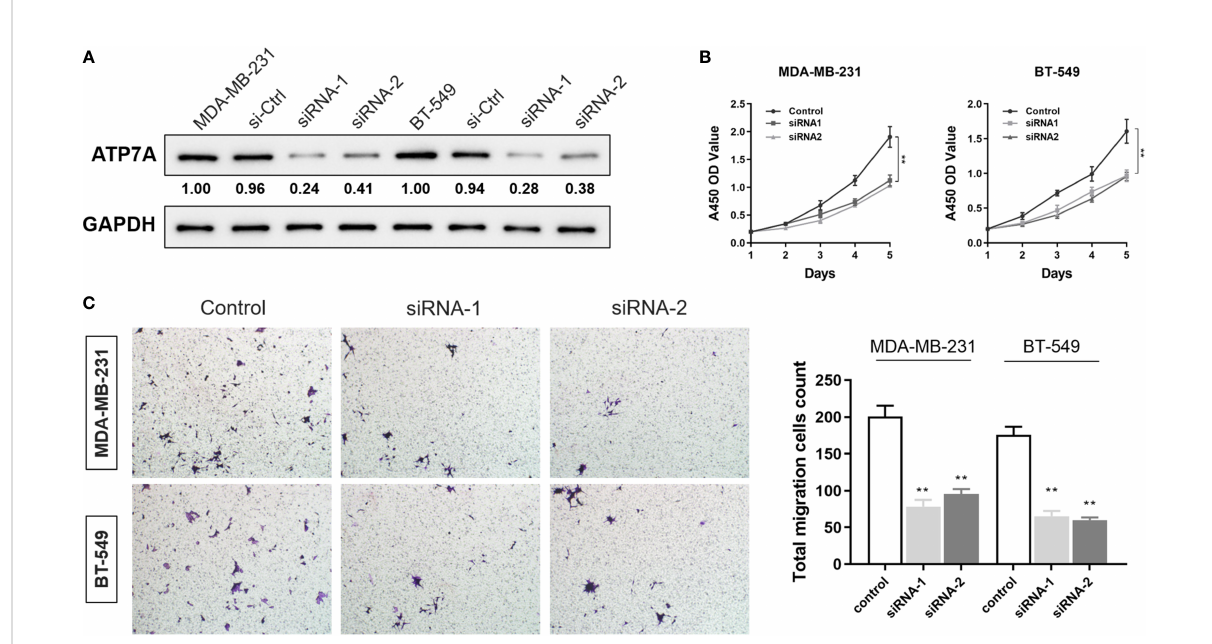
FIGURE 12 Inhibition of ATP7A restrained proliferation and migration capacities of breast cancer cells (A) Western blot analysis revealed the ef fi ciency of ATP7A knocking-down in BT549 and MDA-MB-231 cell lines. (B) CCK-8 cell proliferation assay after ATP7A knockdown in BT549 and MDA-MB- 231 cell lines. (C) The Transwell invasion assay showed that knocking-down of ATP7A inhibited the cellular invasion of the BT549 and the MDA- MB-231.Graphical representation of the number of invasive BT549 and MDA-MB-231 cells per microscopic fi eld. Data were shown as the mean ± SD from three independent experiments. **P < 0.01, vs . control